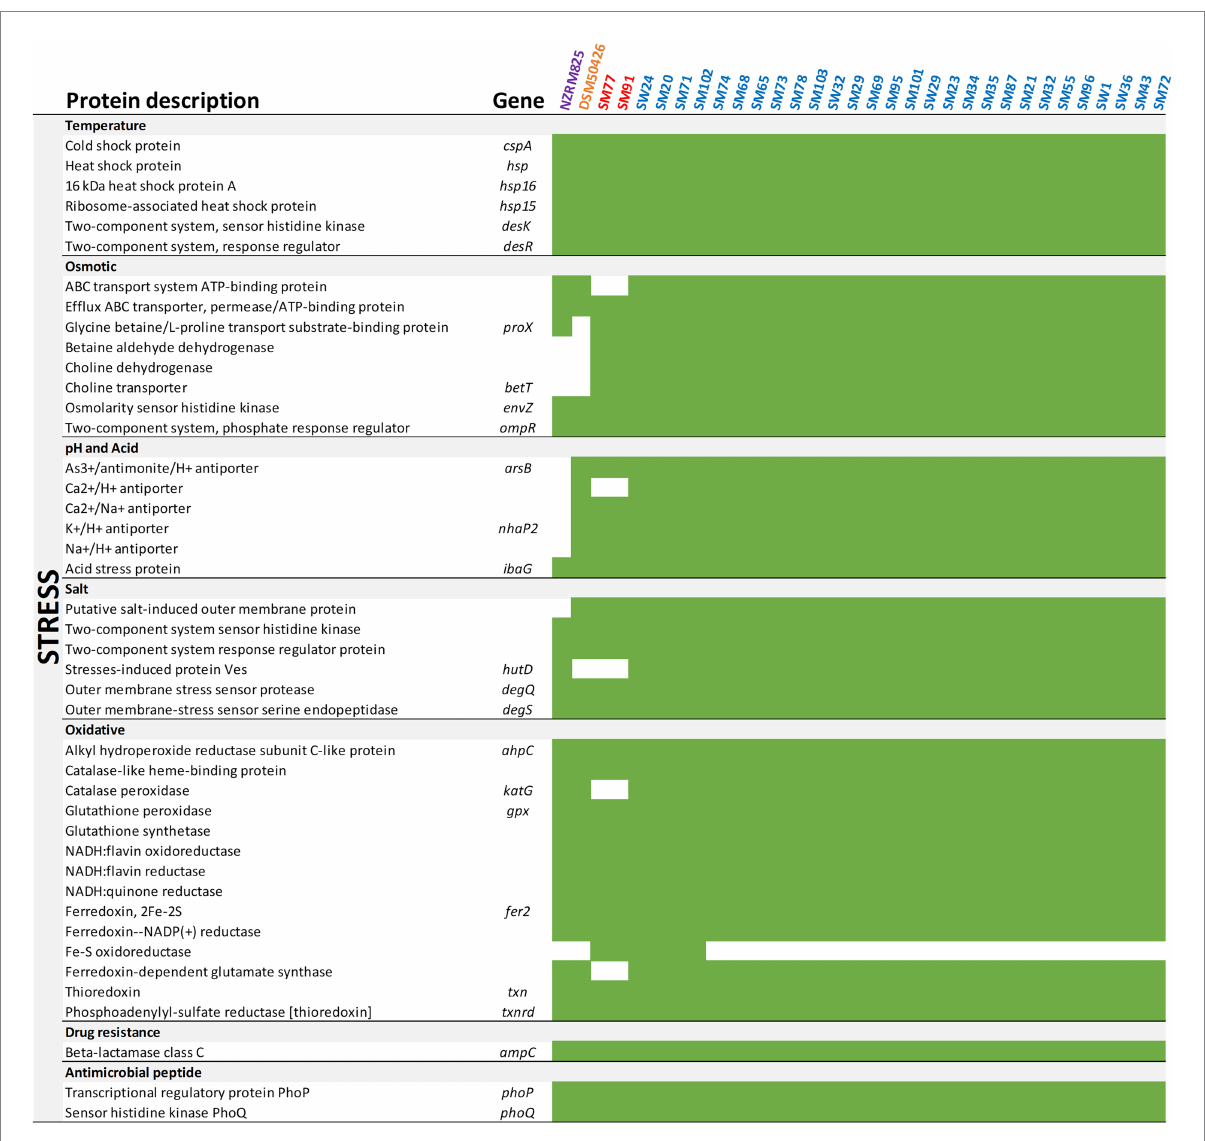
FIGURE 3 Presence of stress-related genes of Shewanella . Presence (green) or absence (white) for each gene is